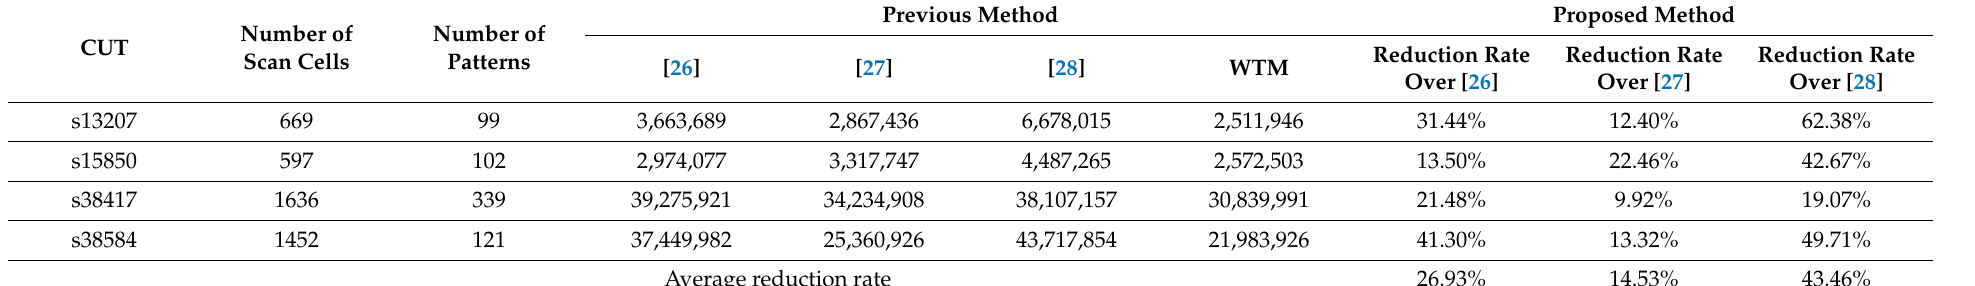
Table 2. Comparison of power consumption with the previous